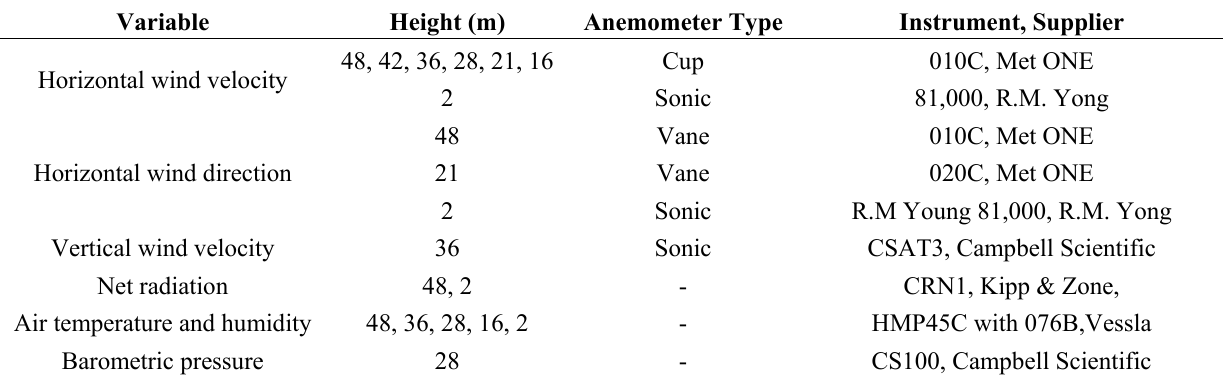
Figure 1. Contour map of the site. Table 1. Instrumentation and measured variables at the flux